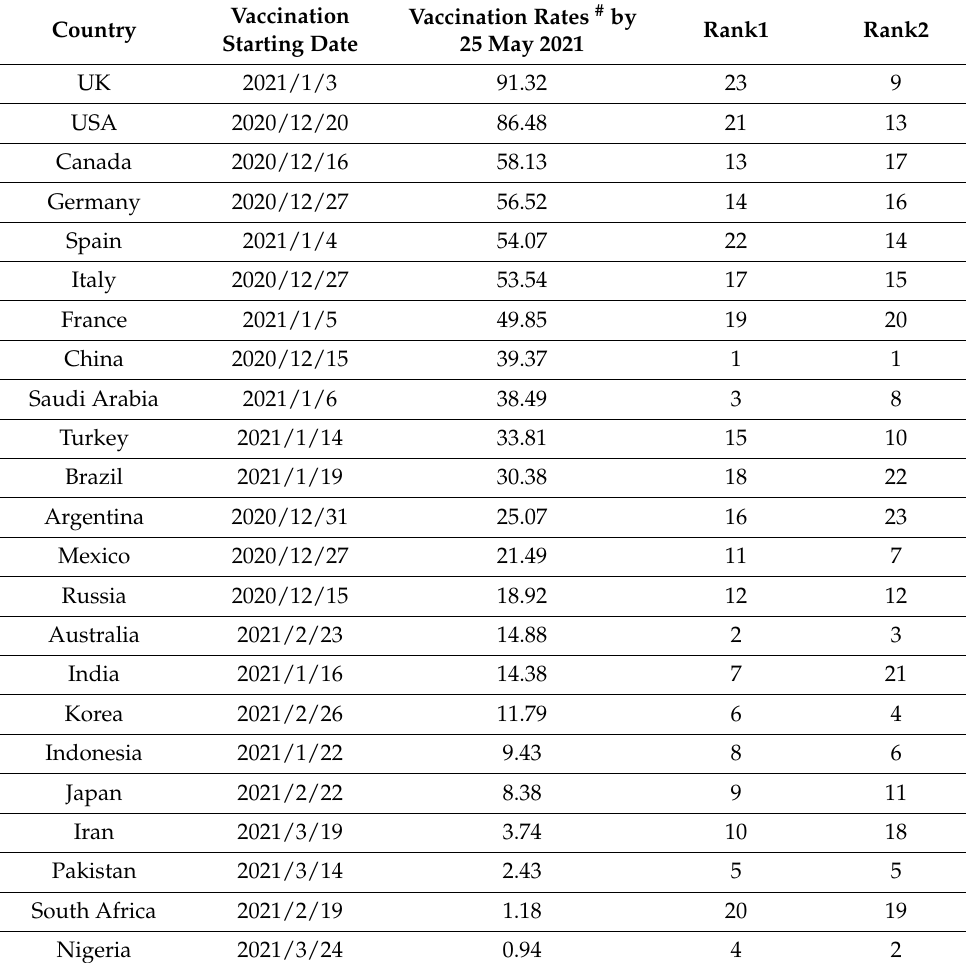
Table 5. The vaccination starting date, cumulative vaccination rates by 25 May 2021, and efficiency ranking in the weeks of 4–10 January (Rank1) and 17–23 May 2021 (Rank2). Vaccination Vaccination Rates # by Country Starting Date 25 May